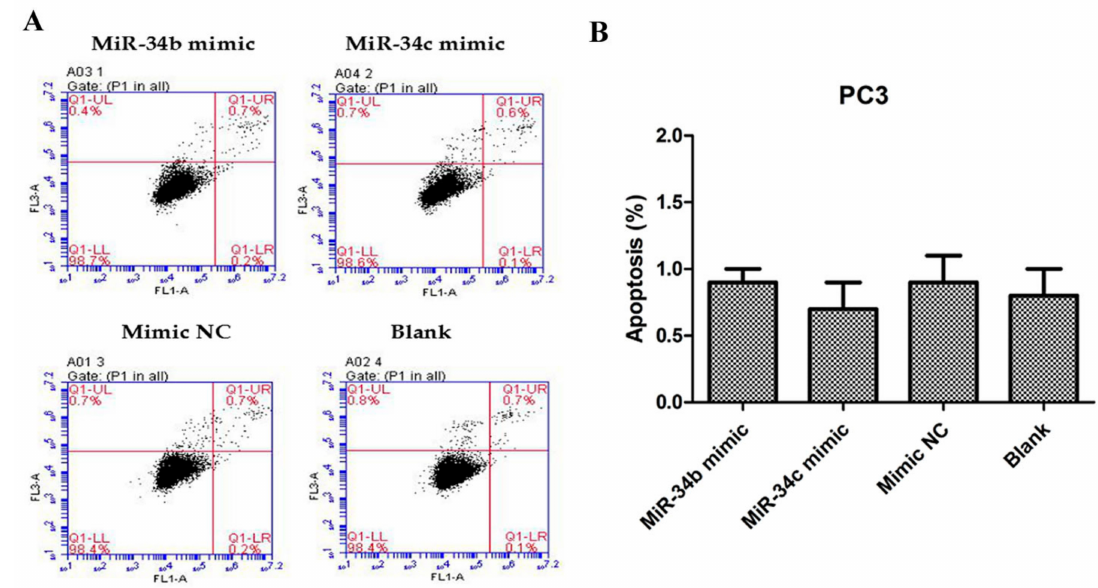
Figure 4. Flow cytometric data of apoptotic PC3 cells, 48 h after transfection with miR-34b/c mimic, mimic NC or without transfection (Blank). ( A ) Cells were harvested, stained with annexin-V-FITC and PI, and analyzed by flow cytometry. ( B ) Data showing the percentages of early and late apoptotic cells (right quadrants).